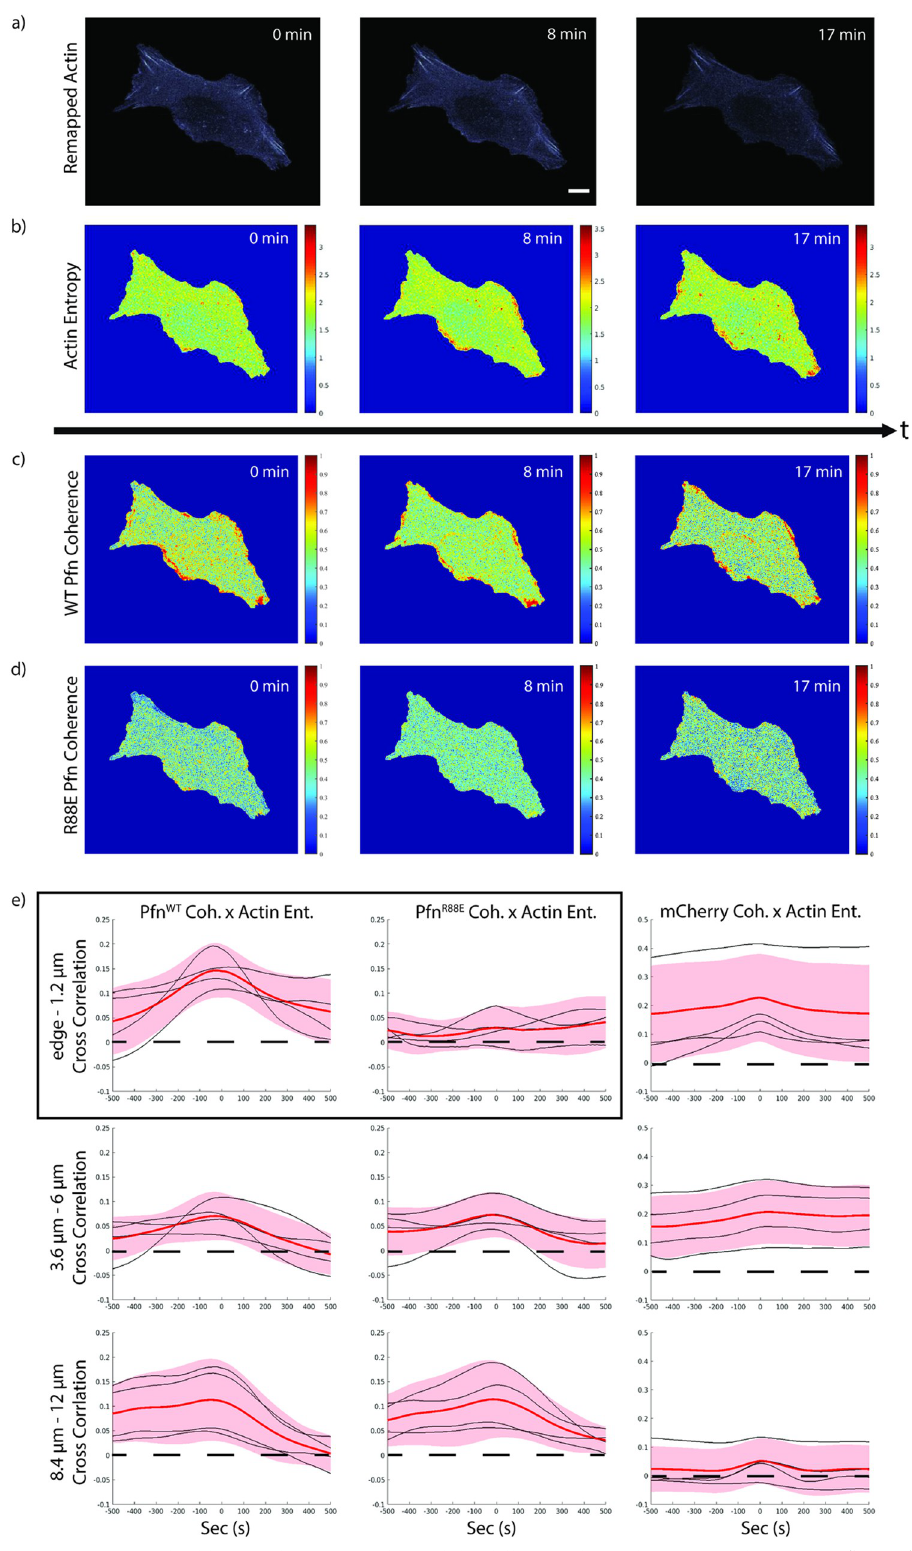
Fig 6. Co-expressed wildtype and mutant Profilin exhibit different relationship to Actin dynamics. a-d) Signal transforms to relate Profilin organization to Actin dynamics. The transforms are enabled by remapping the movie